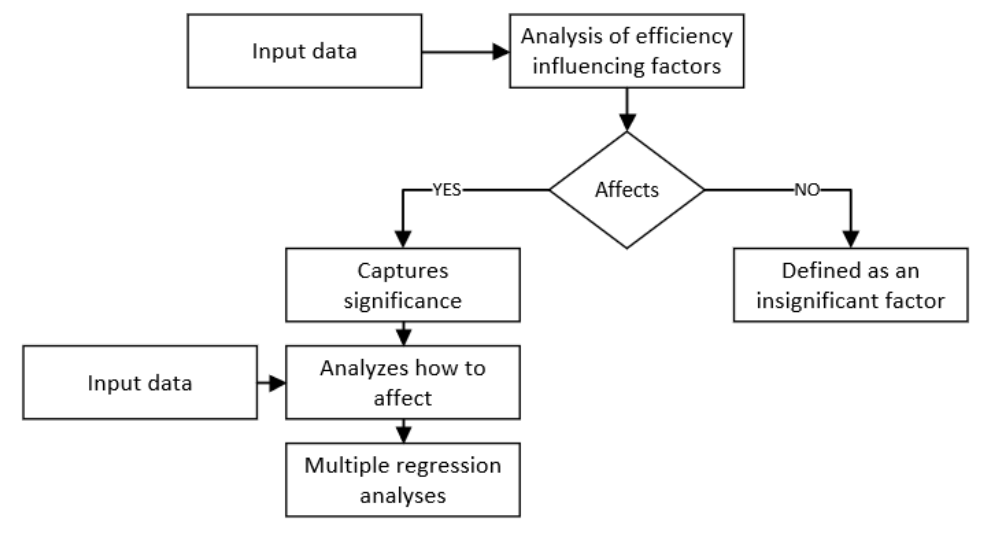
Figure 1. Algorithm of methodology.